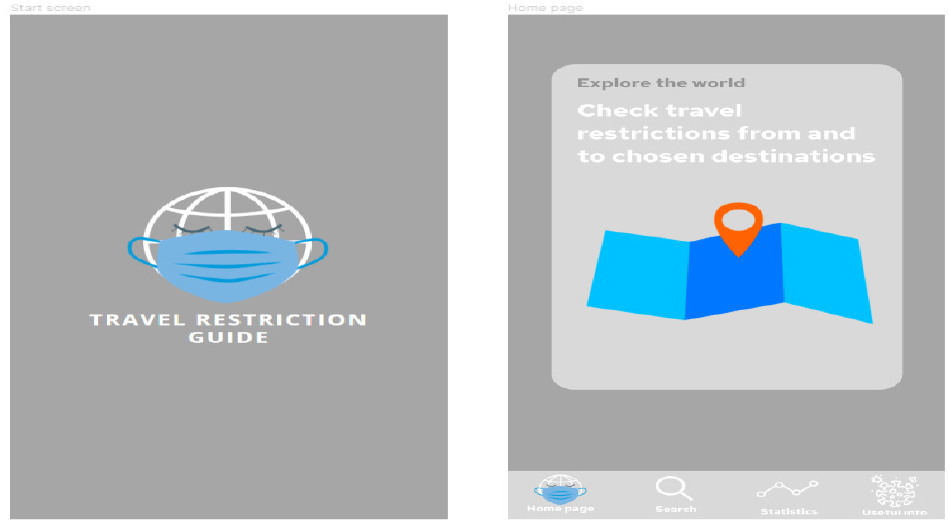
Figure 8. Start screen and home page of the application. These are the first screens that the user sees after launching the application. Source: Authors own elaboration.